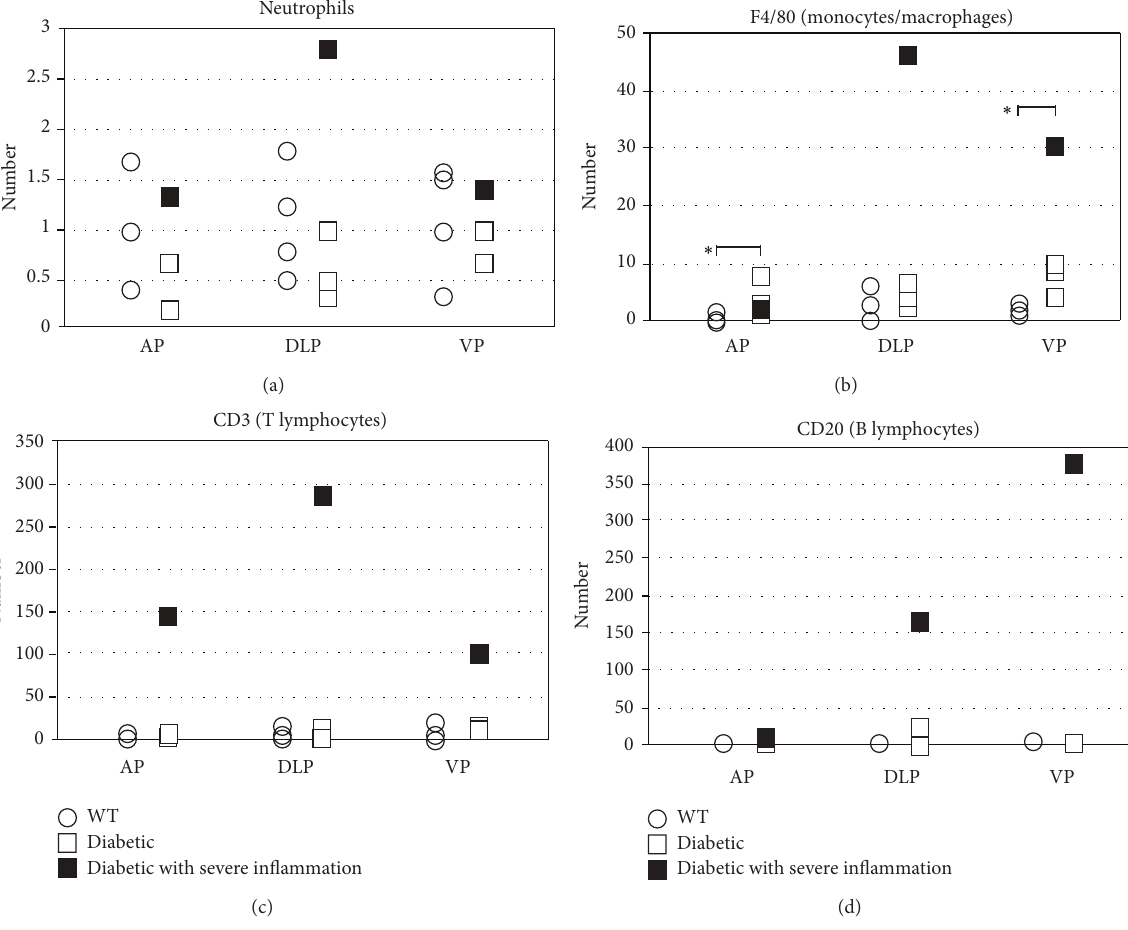
lobe from each animal were acquired (WT: 𝑛 = 4 ; diabetic: 𝑛 = 4 ) using a Spot-advanced camera on an Olympus